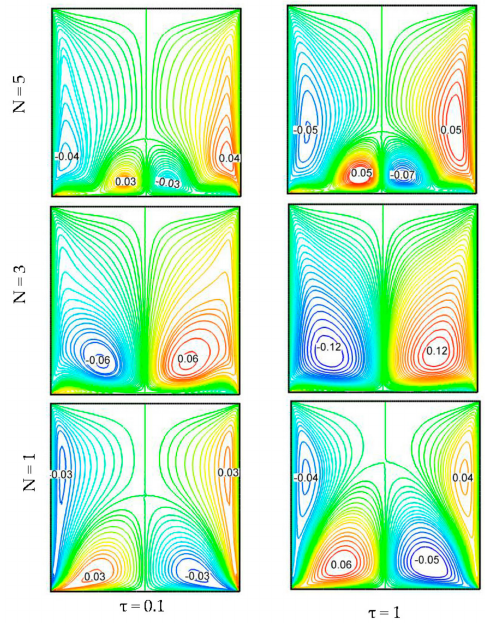
Figure 3. Influence of the odd values of N on streamlines for the selected values of τ with Gr = 10 5